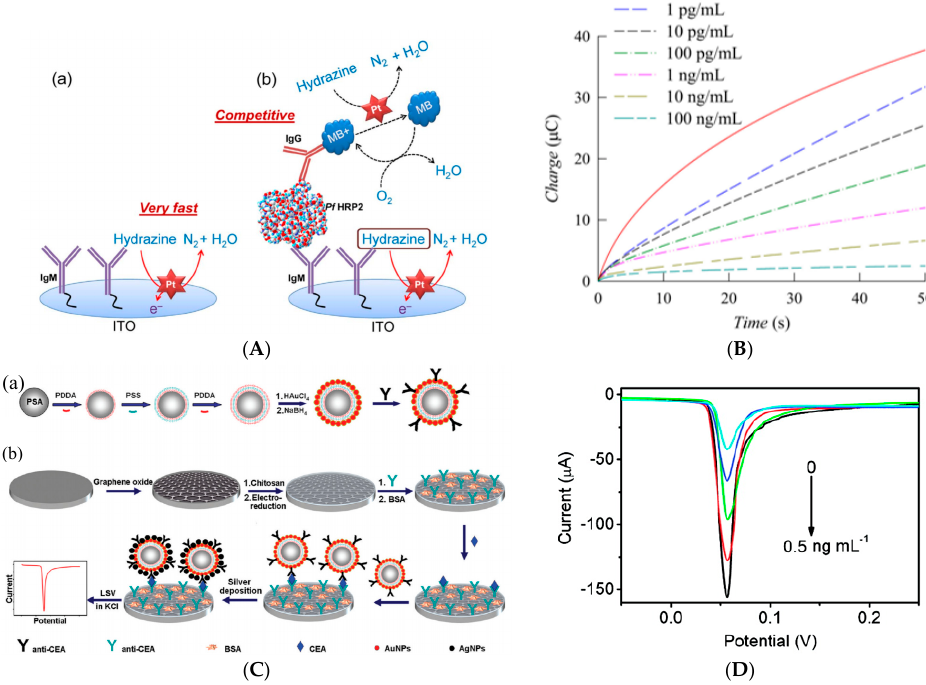
Figure 23. ( A ) Pf HRP2 immunosensor in the absence ( a ) and presence ( b ) of the target antigen with the MB-labelled detection antibody; ( B ) Chronocoulograms of PBS spiked with Pf HRP2 recorded at 0.05 V (vs. Ag/AgCl). Reprinted from [122], Copyright 2016, with permission from Elsevier; ( C ) Scheme of ( a ) construction of signaling AuNPs by layer-by-layer alternate assembly of PDDA and PSS, and ( b ) sandwich immunoassay with Ag deposition and AgNPs redissolution, for CEA detection, on a chitosan/RGO-modified GC electrode; ( D ) Linear sweep stripping voltammetric curves of